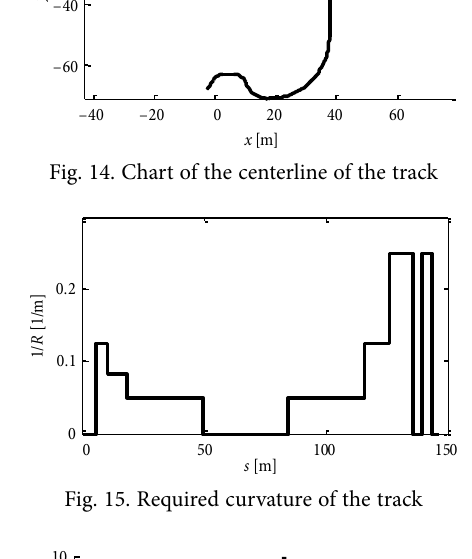
Table 2. Traction powers for traffic conditions with a constant speed on a flat, straight section (or a bend with a radius of curvature greater than 150 m)